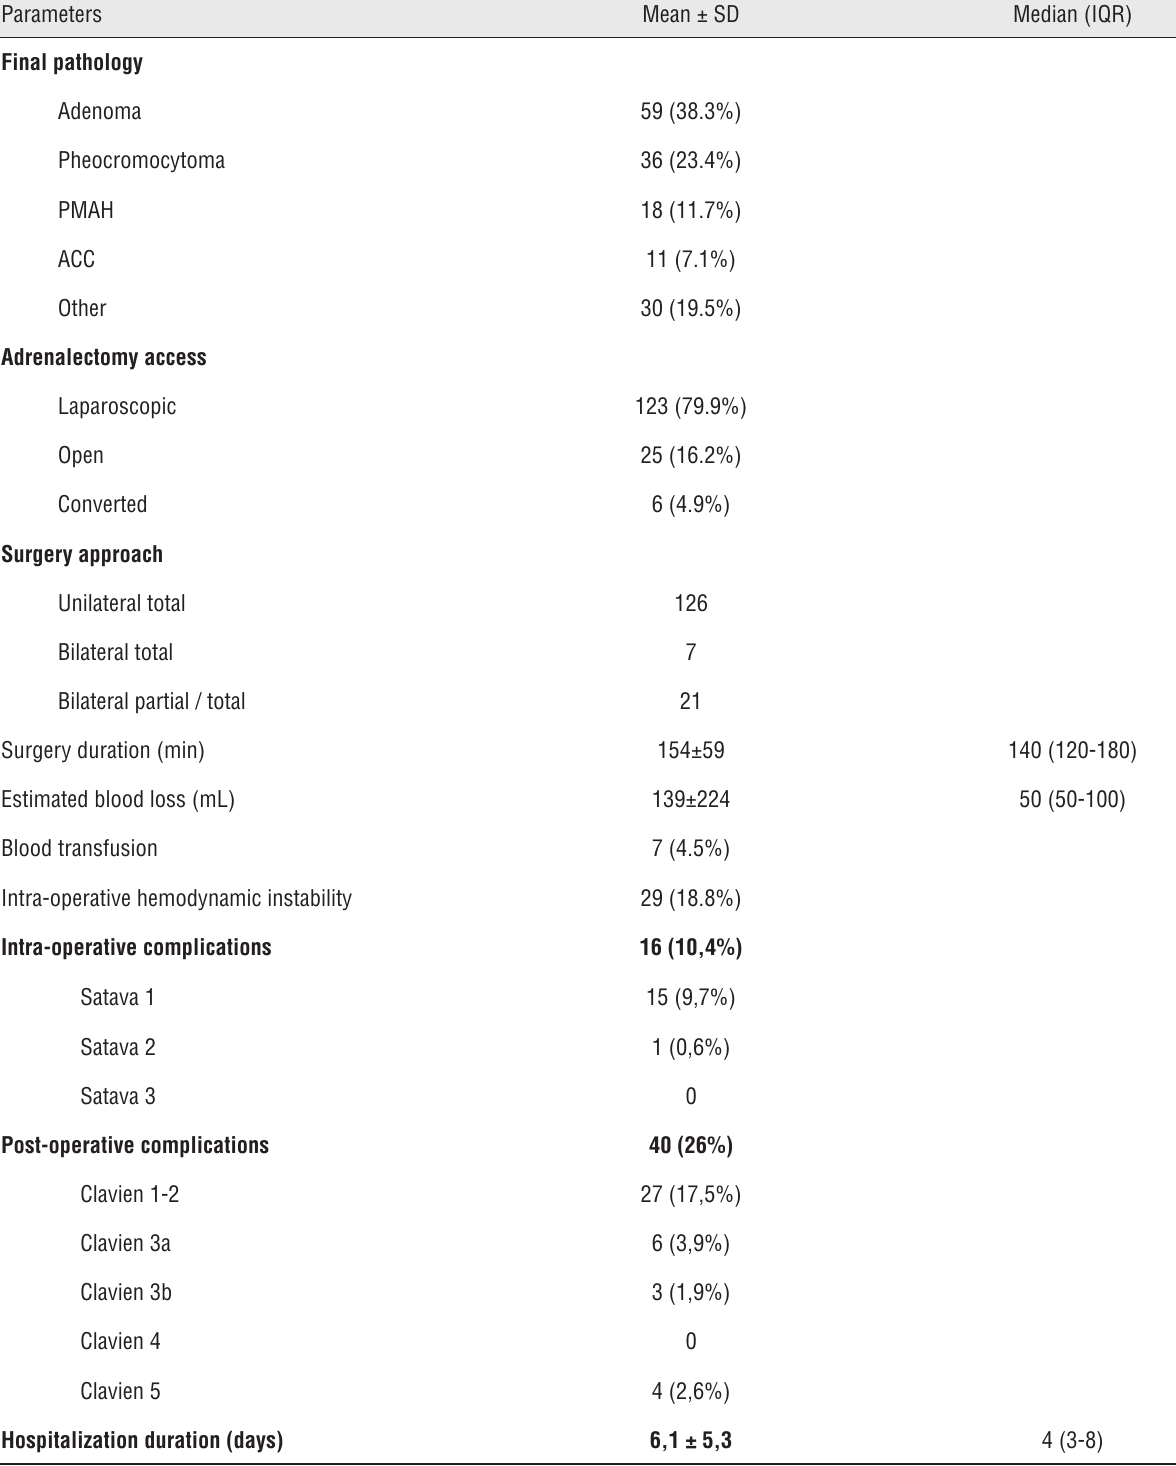
Table 4 – Demographic and clinical presentation